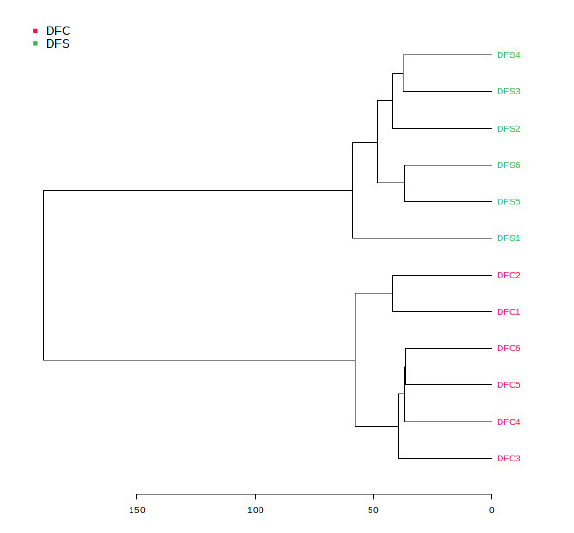
Figure 6. HCA plot showed as dendrogram in unsupervised analysis for DFC and DFS corresponding to the PCA model.